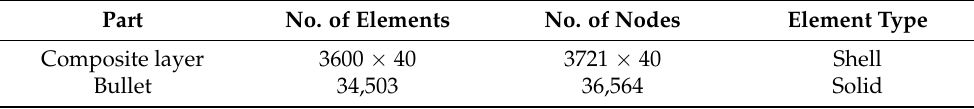
Figure 4. Section view of finite element model for the flat composite body armor plate. Table 2. FEM details for the flat composite body armor plates.